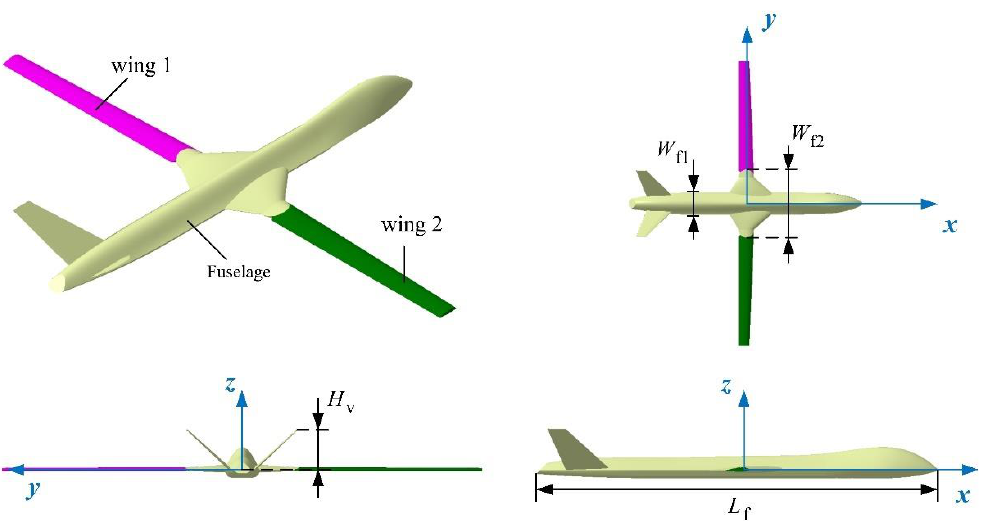
Figure 5. Model of the aircraft with variable swept-back wing. Table 1. Main dimensions of the fuselage.